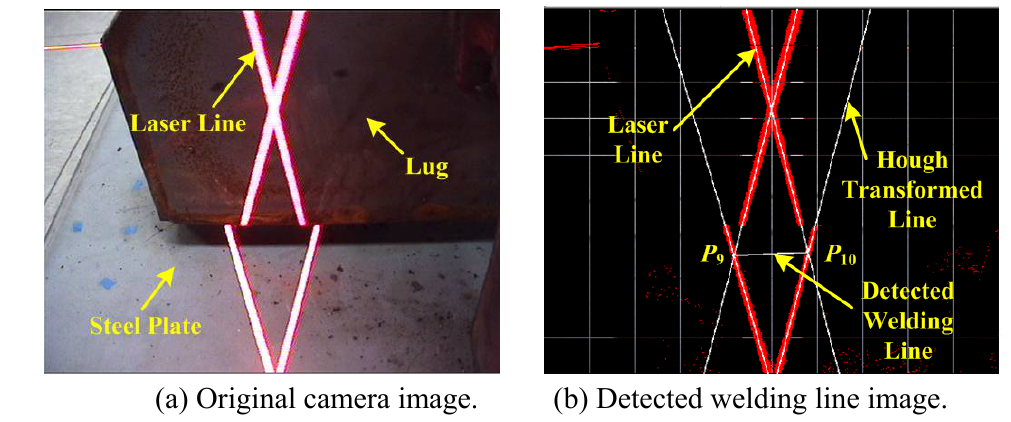
Figure 14. Results of the feature extraction from the side view image.